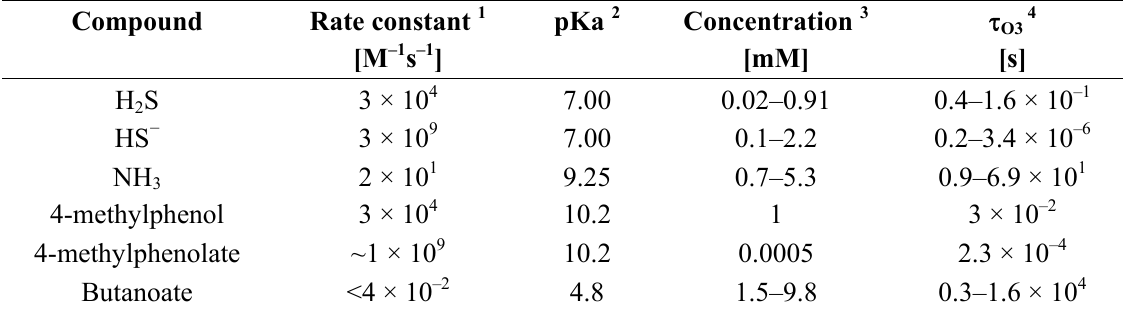
Table 2. Estimated lifetime of ozone upon reaction with manure components present in high concentration and with large reaction rate constants.